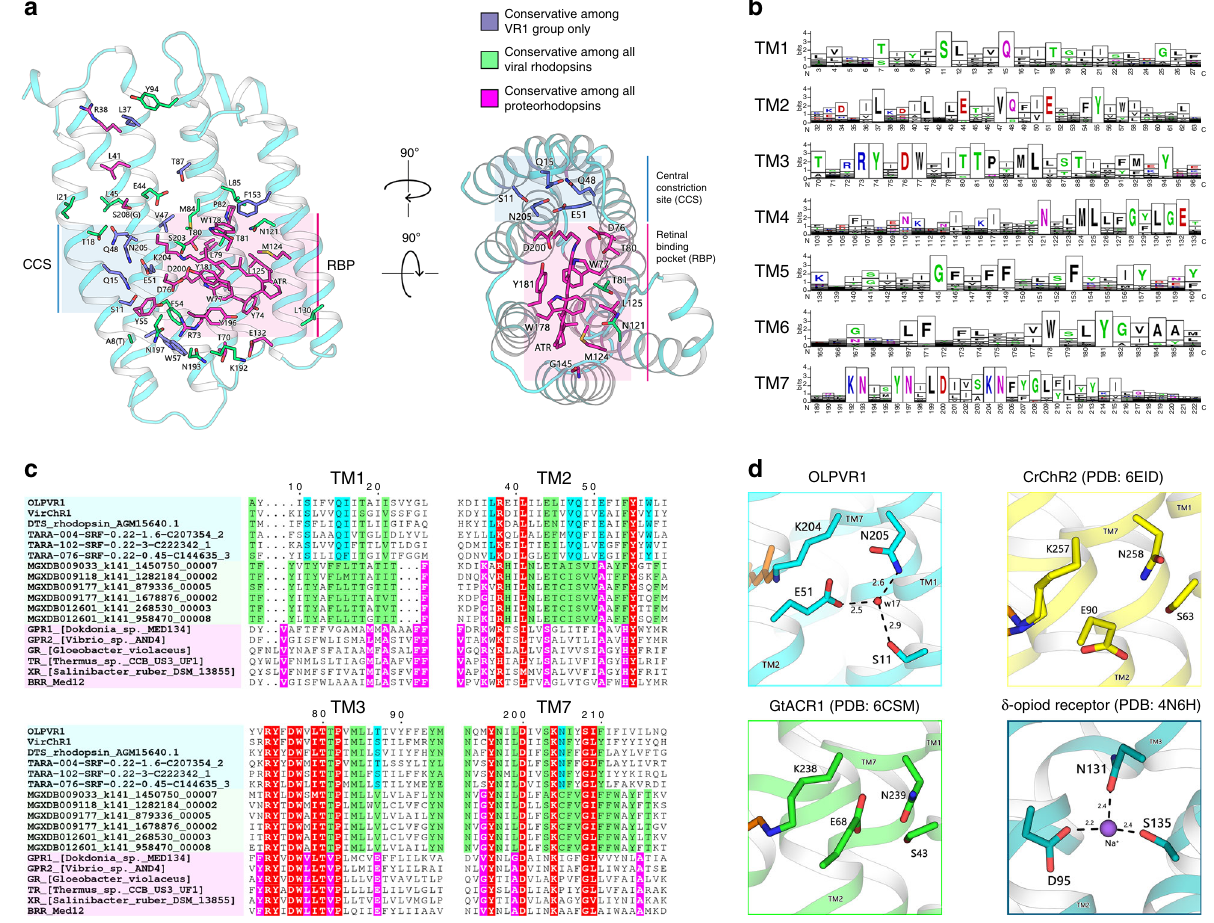
Fig. 6 Conservativity analysis of viral rhodopsins. a Structural overview of highly conservative (70% cutoff) residues among viral rhodopsins family, including both VR1 and VR2 groups ( n = 557). OLPVR1 structure was used as a template of viral rhodopsin, viewed parallel from the membrane (left) and from the cytoplasm (right). Residues conservative among all proteorhodopsins (PRs) and residues exclusively conservative by viral rhodopsins are shown as sticks and colored magenta and dark blue, respectively. b Sequence logo of transmembrane helices (TM1 – TM7) of viral rhodopsins family (both VR1 and VR2 groups) created using Weblogo sequence generator server 106 . c Sequence alignment of TM1, TM2, TM3 and TM7 helices of 6 representative sequences from the VR1 group, the VR2 group and marine PRs, colored light blue, green, and pink, respectively. Residues conservative among the VR1 group, the VR2 group, PRs, and both groups are colored cyan, green, magenta, and red, respectively. d The magni fi ed view of the highly conservative S – E – N triad that comprises central constriction site (CCS) in OLPVR1 (top left), Cr ChR2 (PDB: 6EID 8 , top right), and Gt ACR1 (PDB: 6CSM 10 , down left). The sodium binding site formed by S – D – N triad in the human delta-opioid receptor (PDB: 4N6H 107 , down